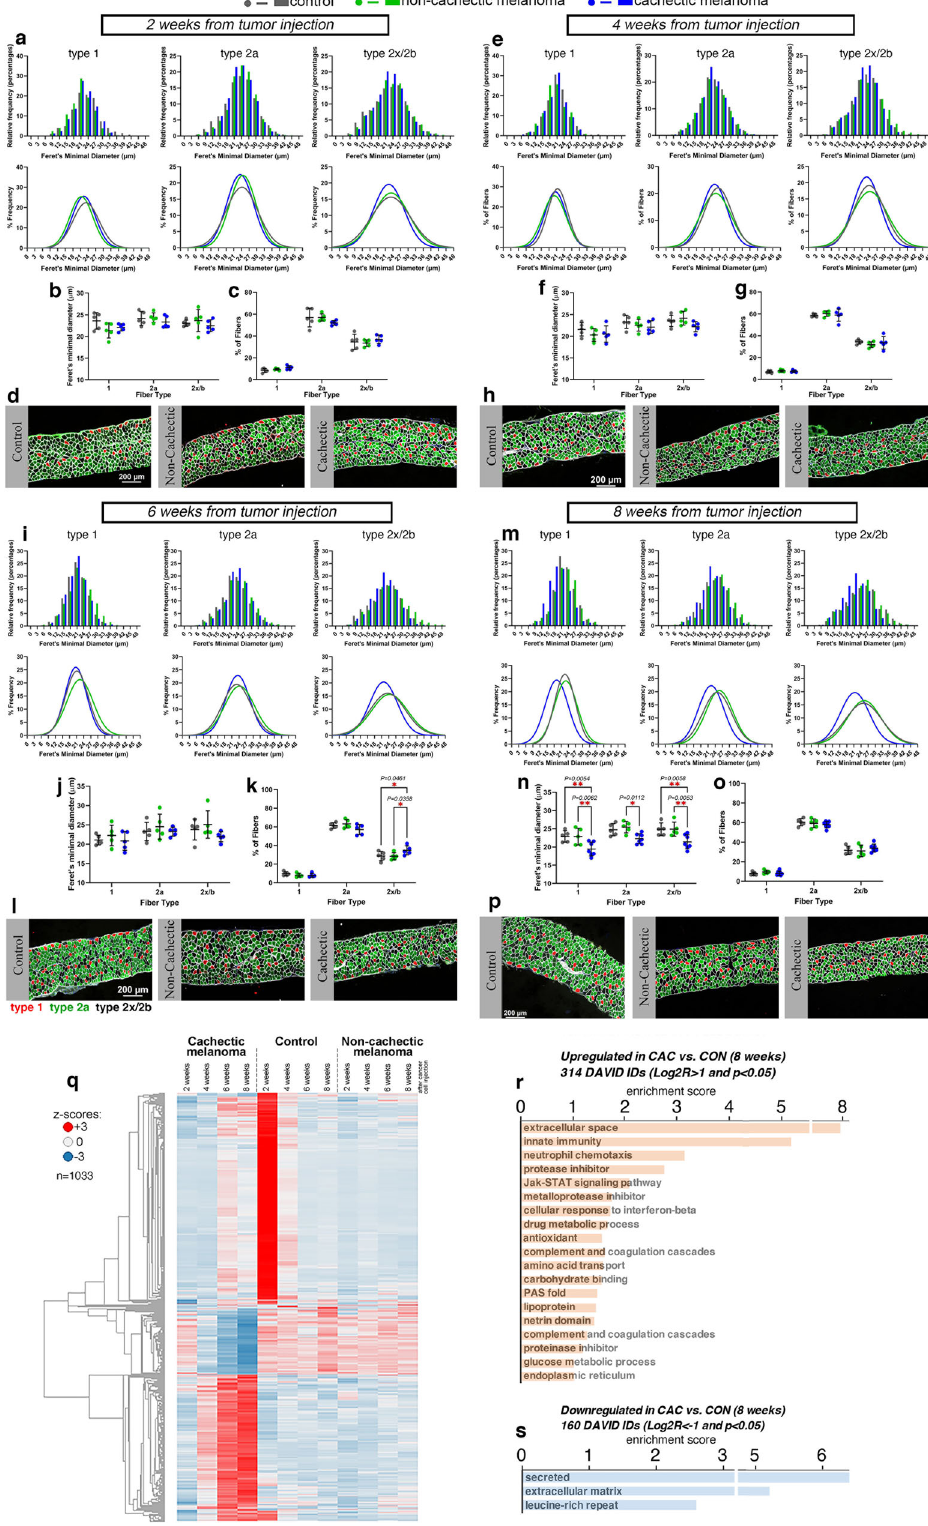
lower in mice implanted with cachectic versus non-cachectic melanoma xenografts (Fig. 7d). The treadmill capacity of rFibcd1- treated cachectic mice trended towards improvement compared to that of mock-treated cachectic mice but this difference did not reach statistical signi fi cance. However, cachectic mice treated